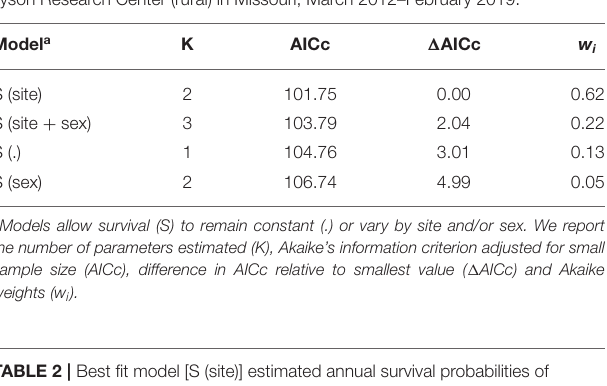
TABLE 1 | Model selection results of candidate models used to estimate survival from mortality of VHF-tagged three-toed box turtles in Forest Park (urban) and Tyson Research Center (rural) in Missouri, March 2012–February 2019.